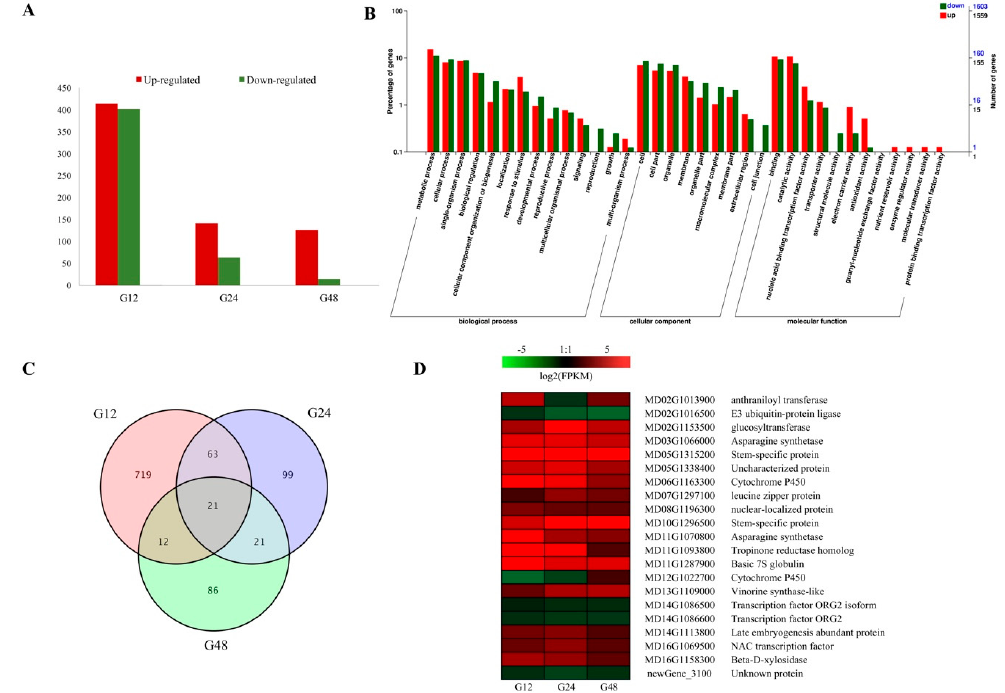
Figure 1. Differentially expressed genes (DEGs). ( A ) Number of DEGs between treated and control samples. DEGs are shown in red (upregulated in inoculated samples) and green (downregulated); ( B ) GO functional enrichment analysis of DEGs; ( C ) Venn diagram depicting number and overlap among DEGs from each time point; ( D ) expression profiles of selected DEGs. The maximum / minimum log 2 FPKM value was set to ± 3.0 (red for upregulated, green for downregulated), each horizontal row represents a DEG while the vertical columns represent 12, 24 and 48 hpi.